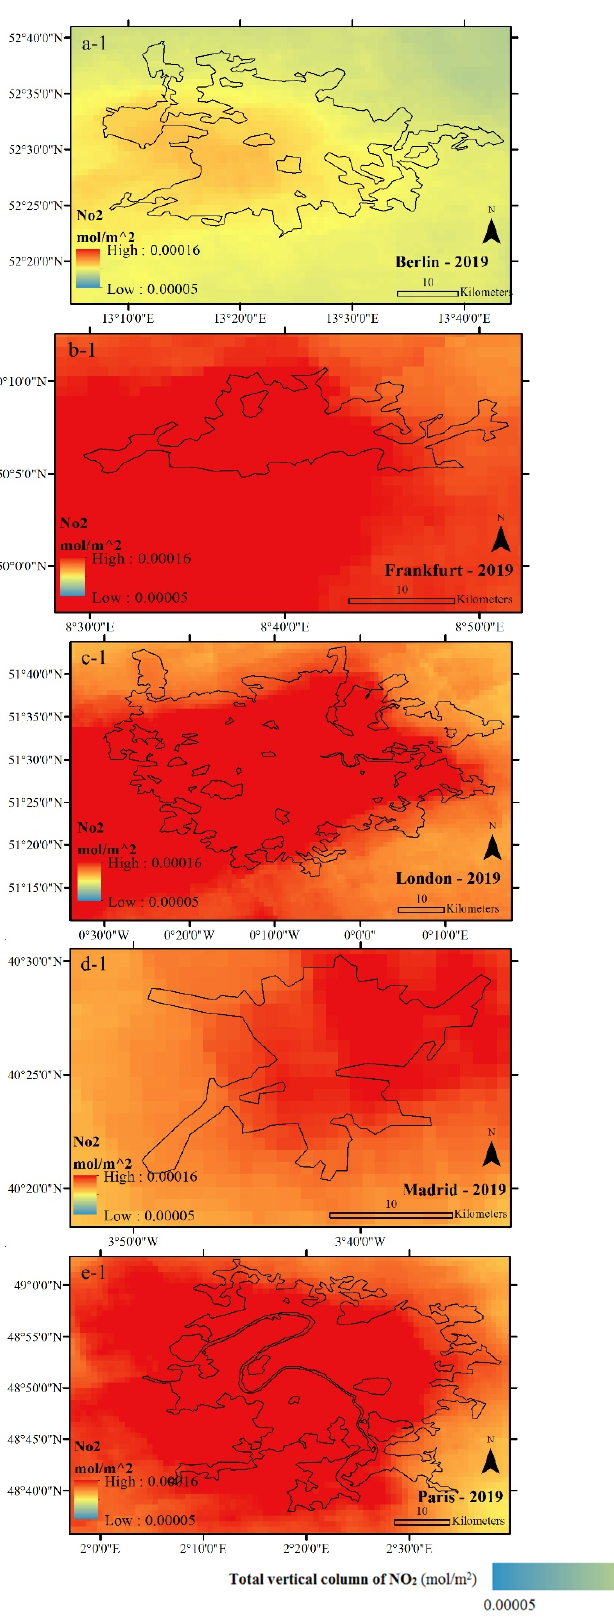
Figure 13. Average NO 2 concentration of the studied cities during CSR, extracted from Sentinel 5P data in mol/m 2 . ( a-1 ) Average NO 2 concentration of Berlin in 2019, ( a-2 ) Average NO 2